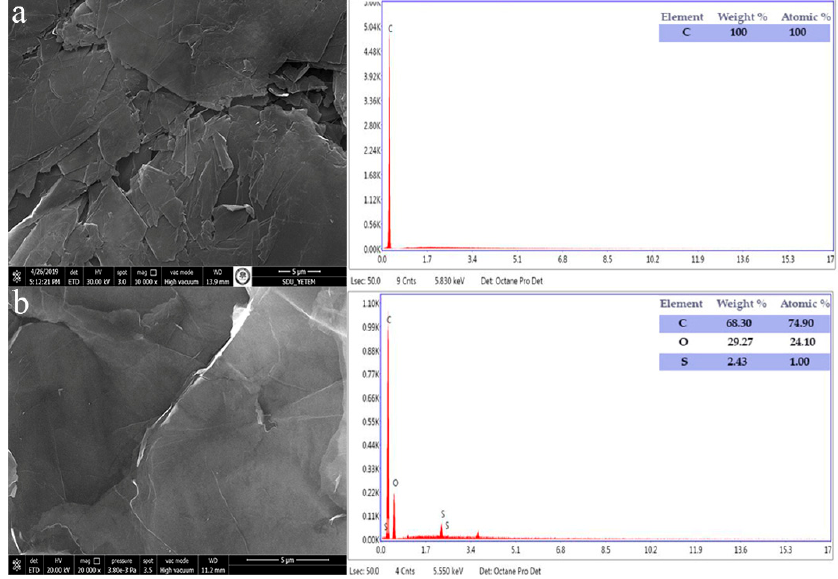
Figure 3. SEM/EDS image of ( a ) graphite and ( b ) GO.